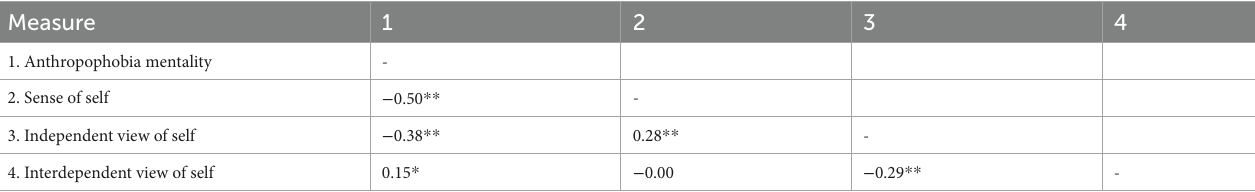
TABLE 3 The correlation among each of these measures to one another in the Japanese samples.